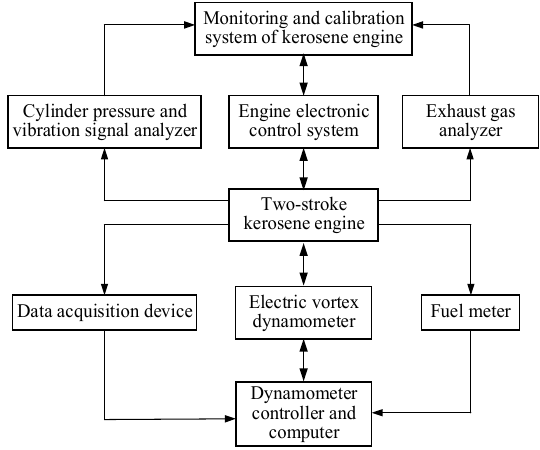
Figure 5. Serial communication circuit.